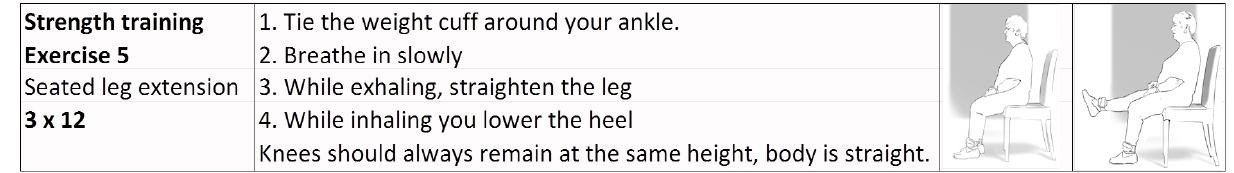
Figure 2. Example of an exercise instruction: intermediate seated leg extension with